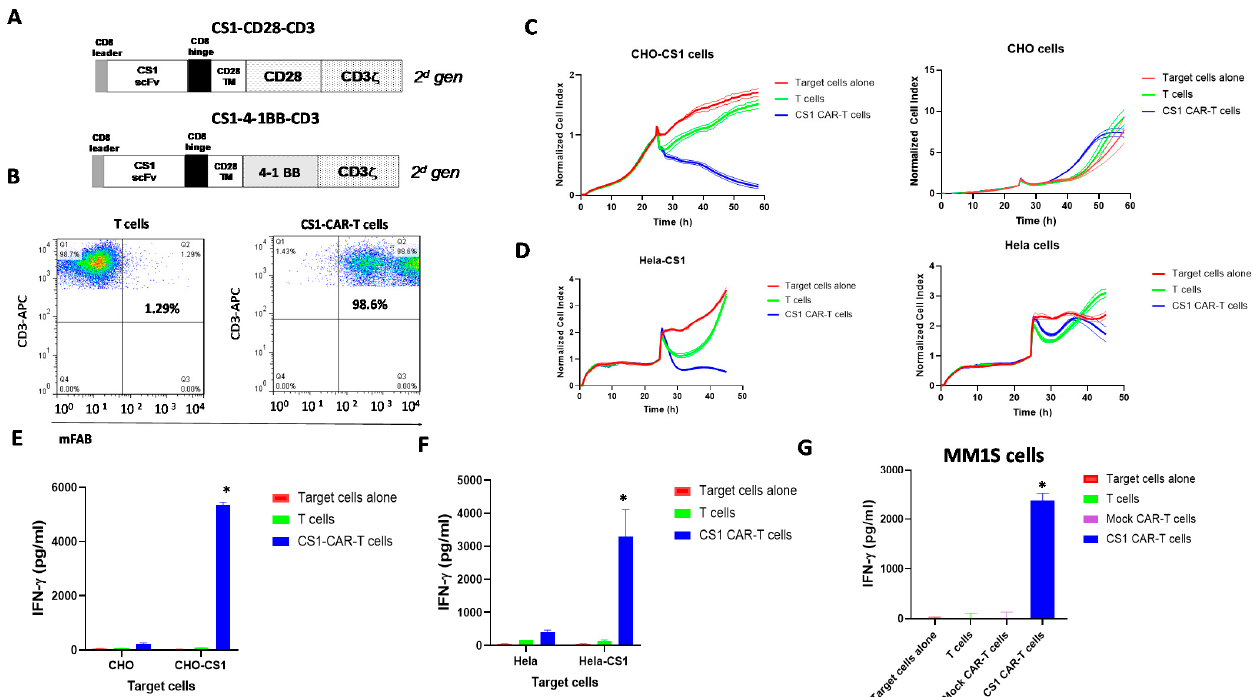
Figure 2. CS1-CAR-T cells target CS1-positive target cells. ( A ) The structure of CS1-CAR constructs. A TM-transmembrane domain, CD28 or 41BB costimulatory domain, and CD3 activation domain were used. ( B ) CS1-CAR-T cells expressed CS1 scFv as detected by FACS with anti-mouse F(ab)’2 antibody. ( C ) CS1-CD28-CD3 CAR-T cells killed CHO-CS1 target cells and did not kill CHO cells. ( D ) CS1-CAR-T cells killed Hela-CS1 and not Hela cells. ( E ) CS1-CAR-T cells secreted higher levels of IFN-gamma than T cells alone with CHO-CS1 cells, * p < 0.05, Student’s t -test. ( F ) CS1-CAR-T cells secreted significantly higher levels of IFN-gamma with Hela-CS1 cells, * p < 0.05 versus T cells. ( G ) CS1-41BB-CD3 CAR-T cells secreted IFN-gamma with multiple myeloma MM1S cells, * p < 0.05 versus T cells and Mock CAR-T cells.